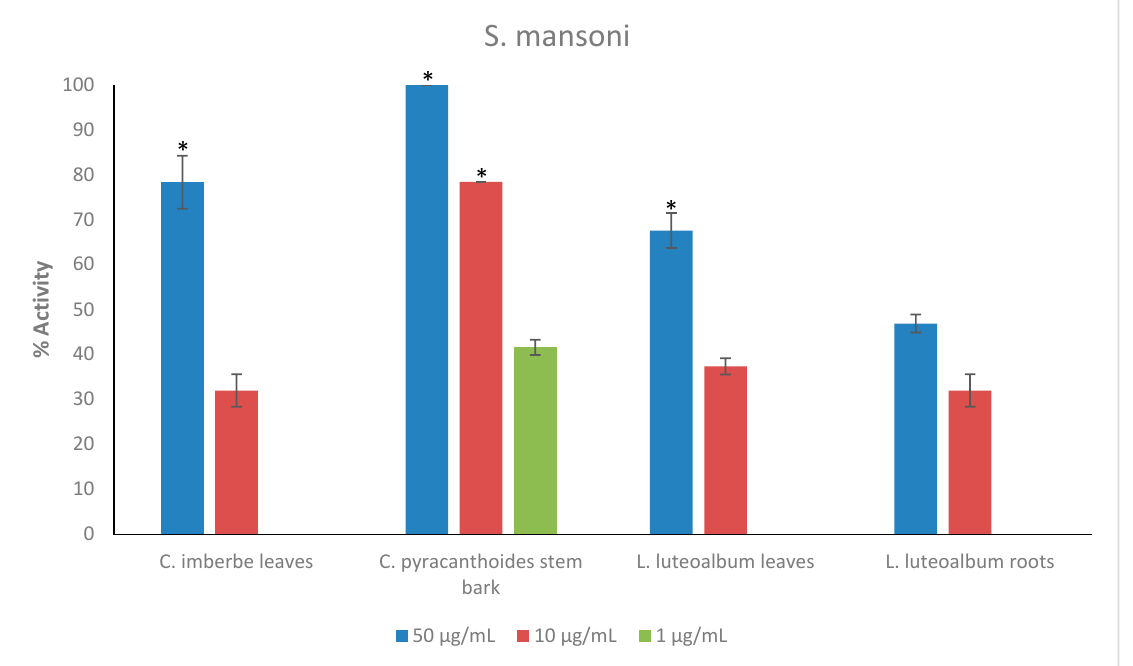
Figure 3. Anthelmintic activity of the plant extracts against S. mansoni . Activity based on three replicates. Statistical analysis (one way ANOVA, p ≤ 0.001, and an all pairwise multiple comparison procedure (Tukey Test), * extract activities determined to be significant) was performed using SigmaPlot 14.0 (Supplementary Materials, Table S5).